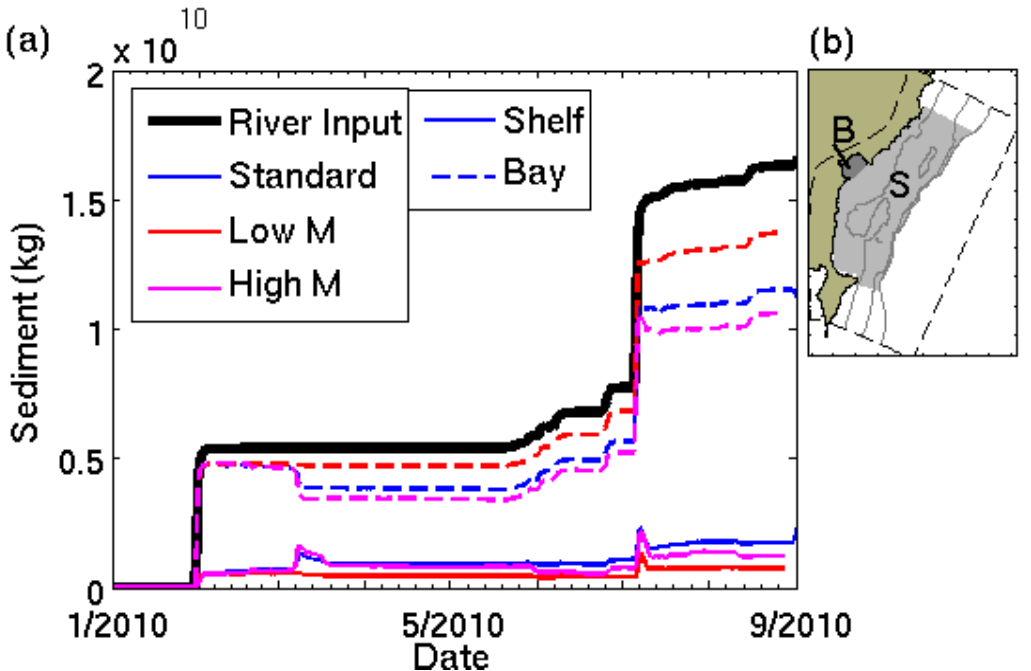
Figure 14. Sediment Budget. ( a ) Time series of cumulative sediment input, mass of sediment in Poverty Bay (B in ( b )), and mass of sediment on the shelf (S in ( b )). Colors indicate sensitivity test. Line style indicates area of model grid included in calculations, as shown in ( b ). ―Shelf‖ includes all areas up to 150 m water depth where no model nudging occurred, excluding Poverty Bay. Model grid boundaries were indicated by dashed line. Bathymetric contours were drawn every 50 m up to 150 m